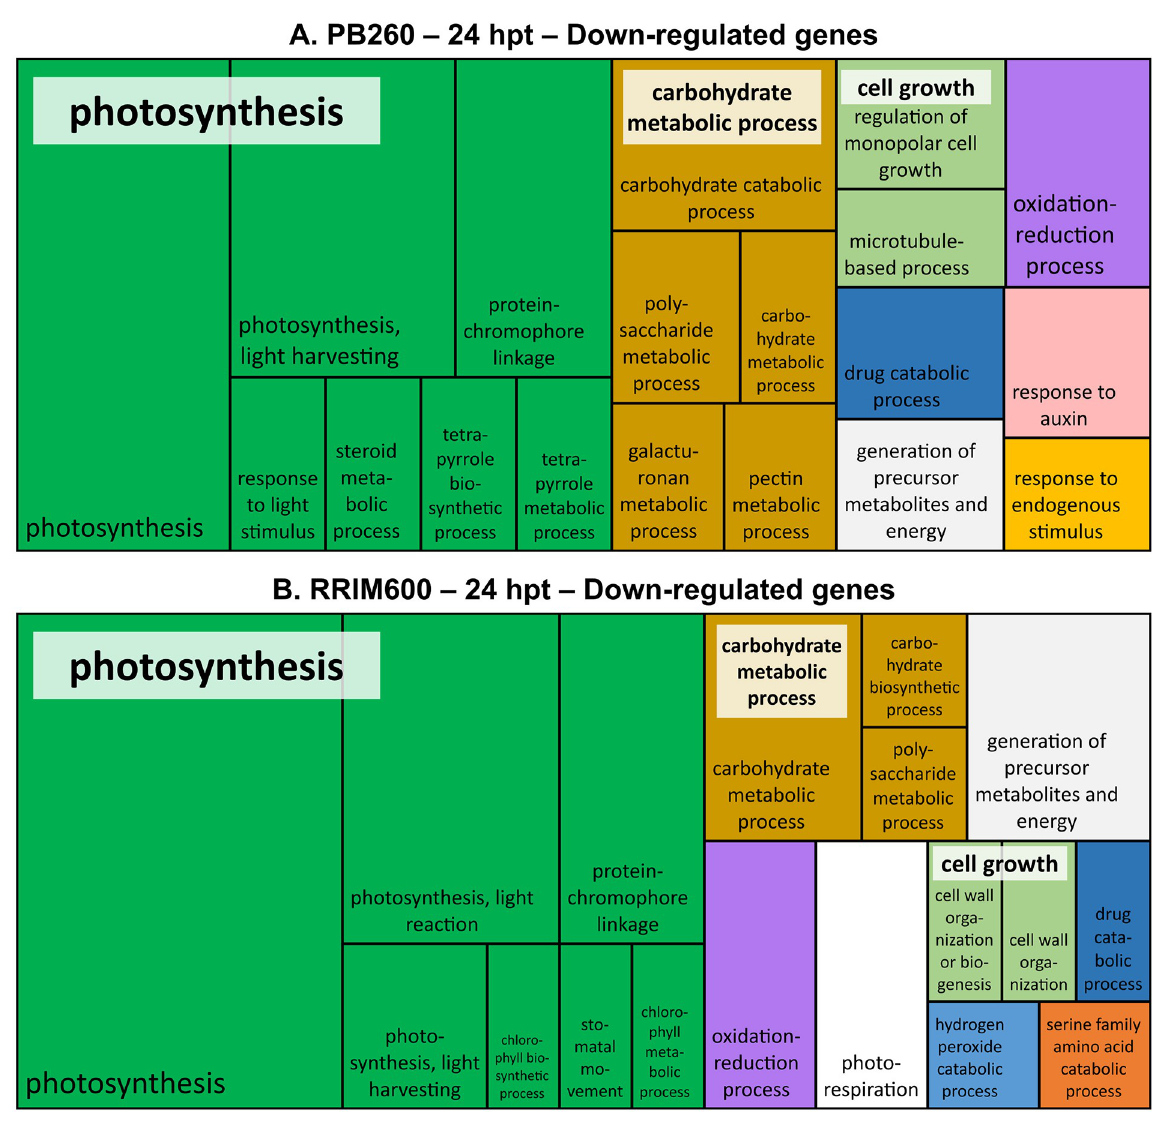
Fig 4. REVIGO treemap representation summarizing GO biological process categories over-represented from PB260 (A) and RRIM600 (B) down-regulated genes. Treemaps were performed only for 24 hpt DEGs. They were built using the percentages of genes annotated with the non-redundant GO terms from S4 Table (REVIGO treemap % column). Each rectangle represents a significant GO term, sometimes joined into colorized superclusters of loosely related terms, whose names are labelled in white squares. The size of the rectangles is proportional to the p- value given by the Blast2GO analysis (i.e. the larger the rectangle, the more significant the